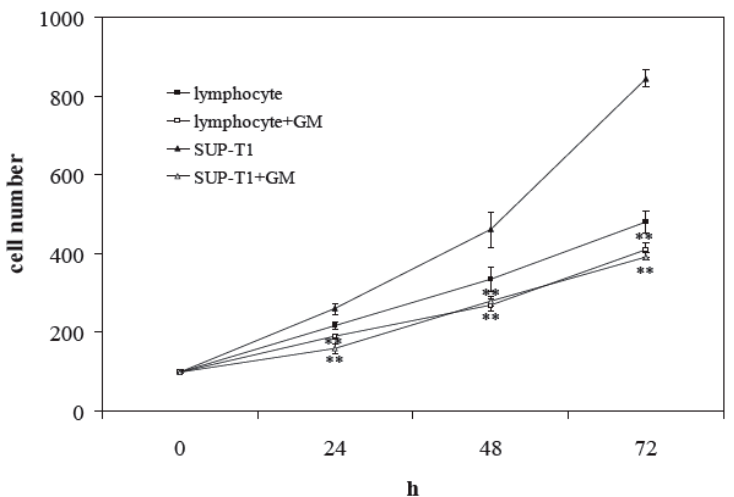
Figure 2. Effect of gentamicin (GM) on lymphocytes and SUP-T1 cells over time. The cell number was evaluated at 0, 24, 48 and 72 h of culture in the presence of 2 mM gentamicin. Data are expressed as the mean ± SD of three independent experiments performed in duplicate. ** p < 0.001.